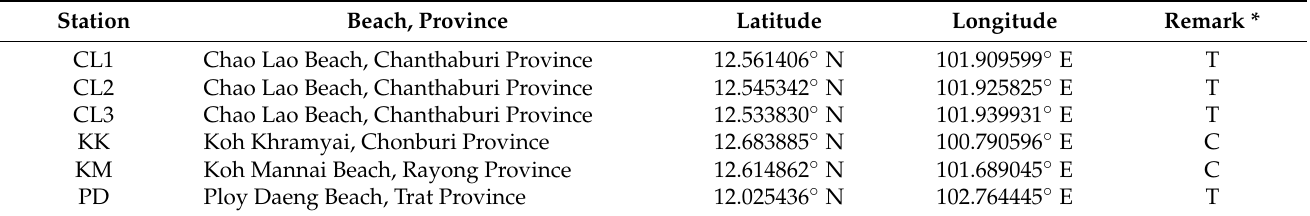
Table 1. Position of sampling stations at four beaches in the eastern part of Thailand in 2018.